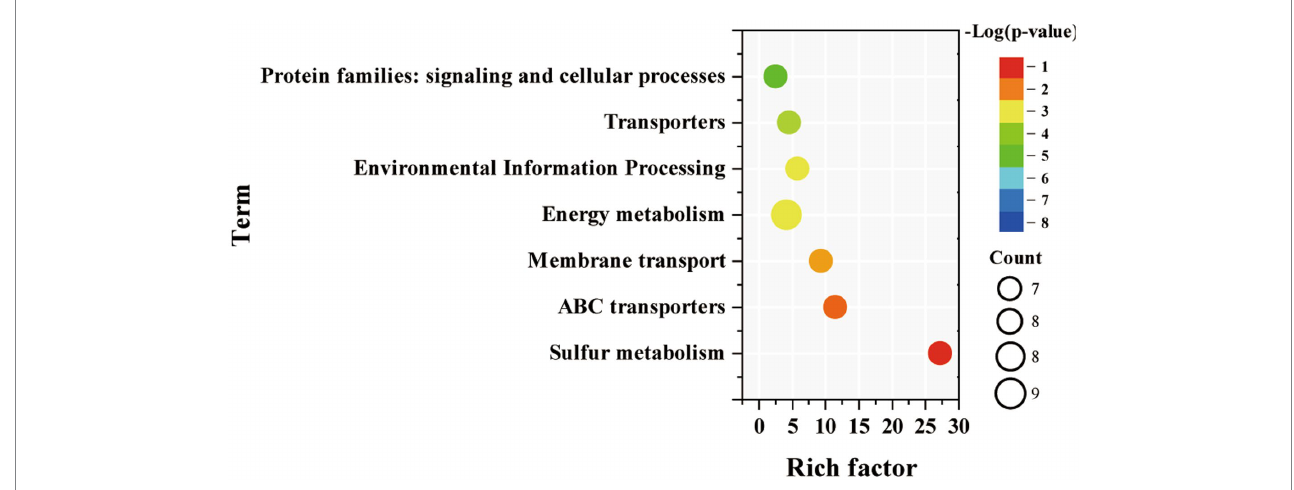
FIGURE. 6 Enriched pathway terms of down-regulated DEGs in Syn7942/ Δ sps-ect grown in 300 mM NaCl condition compared to